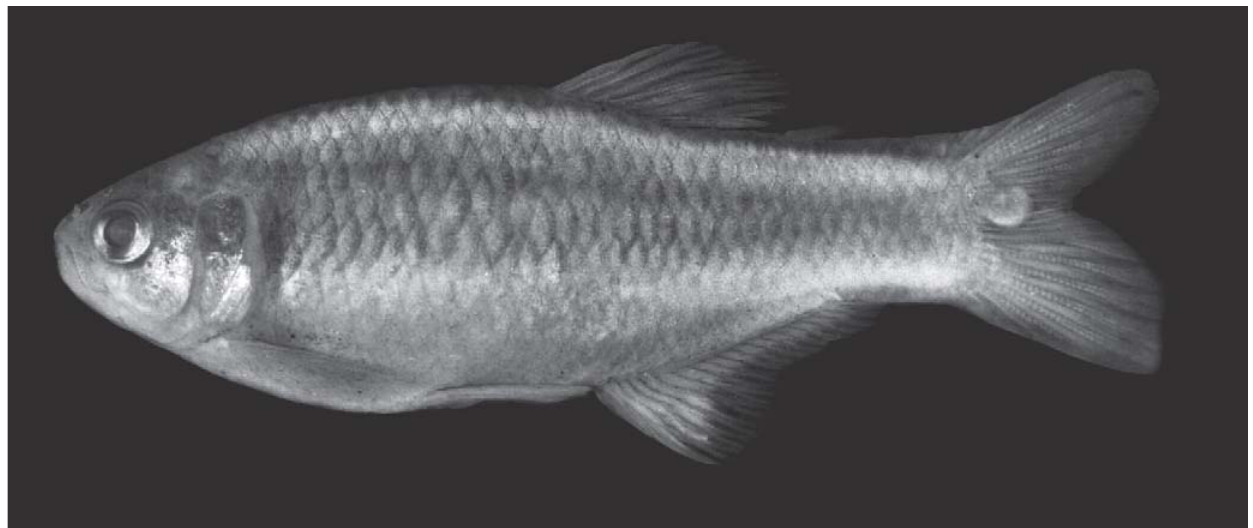
Fig. 20. Glandulocauda caerulea , adult male, USNM 326756, 43.9 mm SL, Brazil, Paraná State, brook tributary to rio Iguaçu near Lara Maria Ranch.